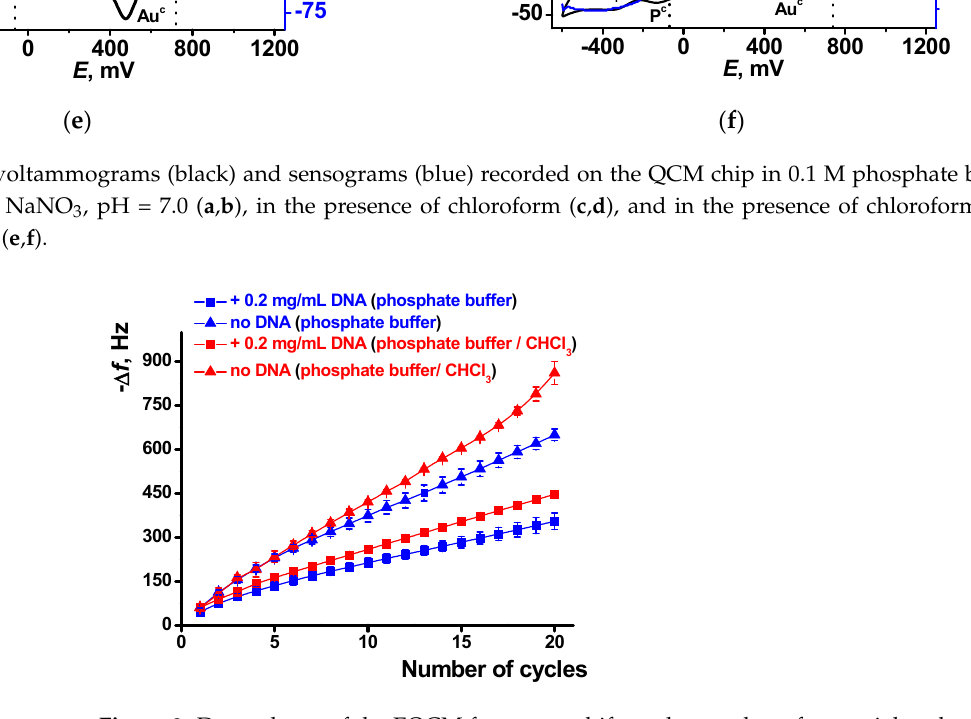
Figure 7. Cyclic voltammograms (black) and sensograms (blue) recorded on the QCM chip in 0.1 M phosphate buffer containing 0.1 M NaNO 3 , pH = 7.0 ( a , b ), in the presence of chloroform ( c , d ), and in the presence of chloroform and 0.2 mg/mL DNA ( e , f ).